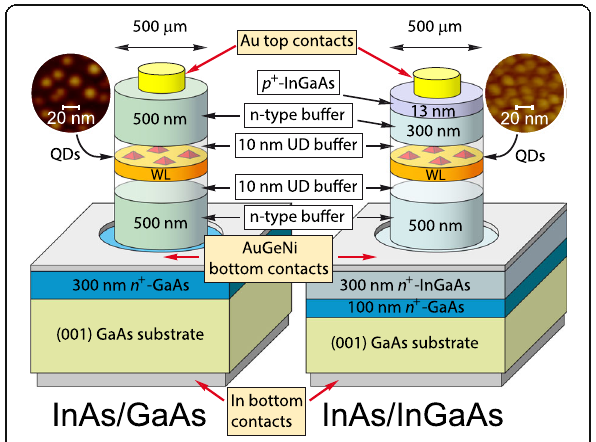
Fig. 1 (Color online) schematics of the metamorphic InAs/In 0.15 Ga 0.85 As/ si -GaAs (right) and InAs/GaAs/ si -GaAs (left) QD samples investigated;